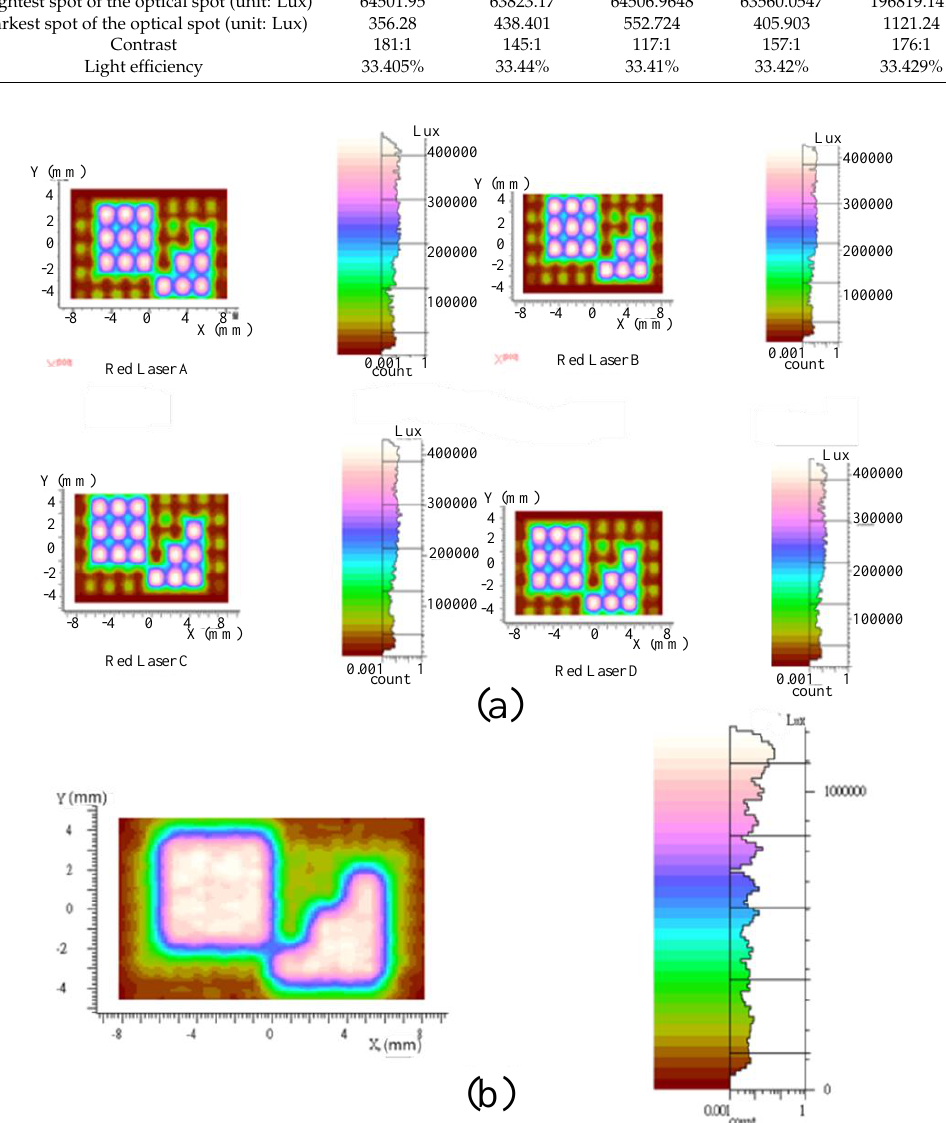
Figure 14. ( a ) Single red laser, displaying displacement map for local dimming (liquid crystal lens with pore size of 2.0 mm and a focal length of 23 cm). ( b ) Four red lasers, displaying compensation for light source micro scanning (liquid crystal lens with pore size of 2.0 mm and a focal length of 23 cm).